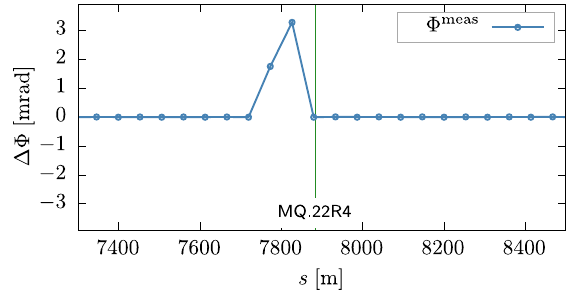
FIG. 3. The impact of a focusing error on the local observable. The plot shows an LHC arc with a relative error of 0.1% of the magnetic field of focusing quadrupole MQ.22R4 which is marked by a vertical